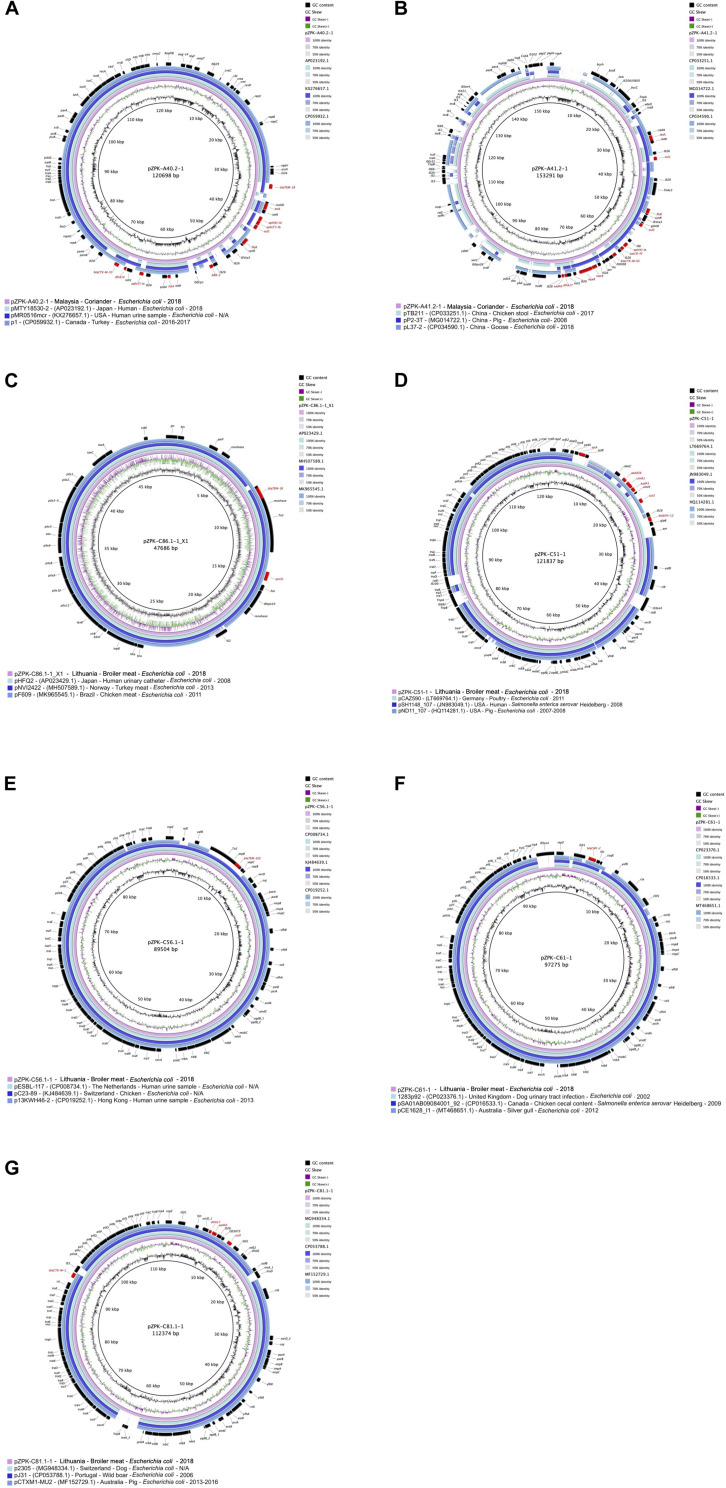
Circular comparisons of the studied plasmids to previously published similar plasmids (GenBank accession numbers are provided in parentheses in the figure legends after plasmid name, followed by country, source, bacterial species and year of isolation; N/A, not available). GC content and GC skew of the studied plasmids are depicted in the inner map with distance scale and the outer ring represents predicted coding sequences with antimicrobial resistance genes highlighted in red. The plasmids in this study included (A) pZPK-A40.2-1, (B) pZPK-A41.2-1, (C) pZPK-C86.1-1_X1, (D) pZPK-C51-1, (E) pZPK-C56.1-1, (F) pZPK-C61-1 and (G) pZPK-C81.1-1.